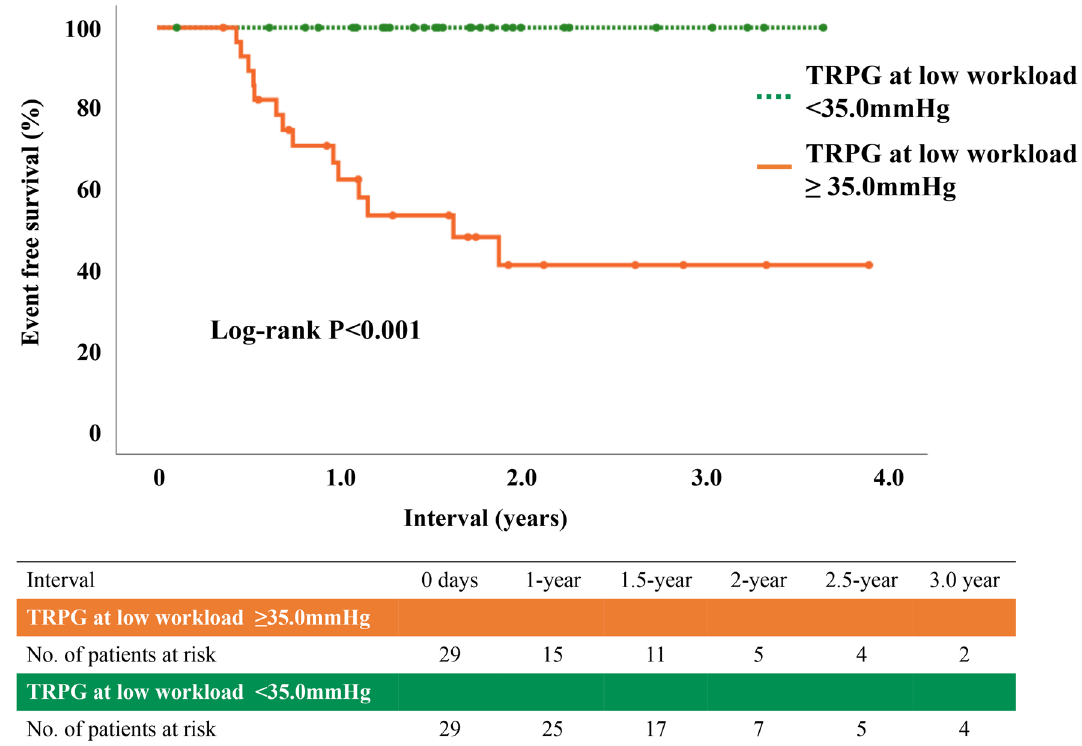
Figure 3. A Kaplan–Meier curve of the cumulative event free survival rates of the endpoint for 2 groups of patients with or without TRPG ≥ 35.0 mmHg at low workload. TRPG tricuspid regurgitation peak